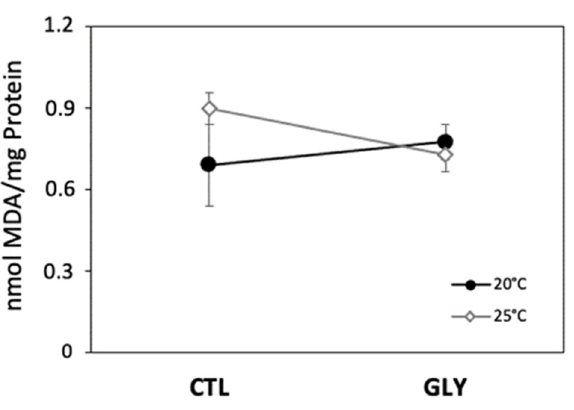
Figure 3. Lipid peroxidation expressed as the lipid peroxidation (MDA) concentration in snails among different exposure conditions at 20 °C and 25 °C (CTL: control group and GLY: glyphosate exposed group). Values are expressed as mean ± SEM (n = 6).